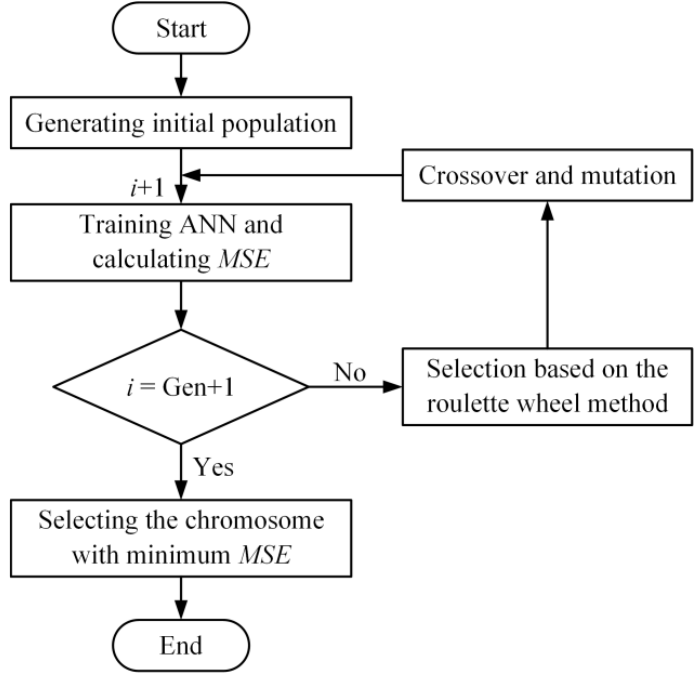
Figure 3. Flowchart of optimizing ANN with the GA.